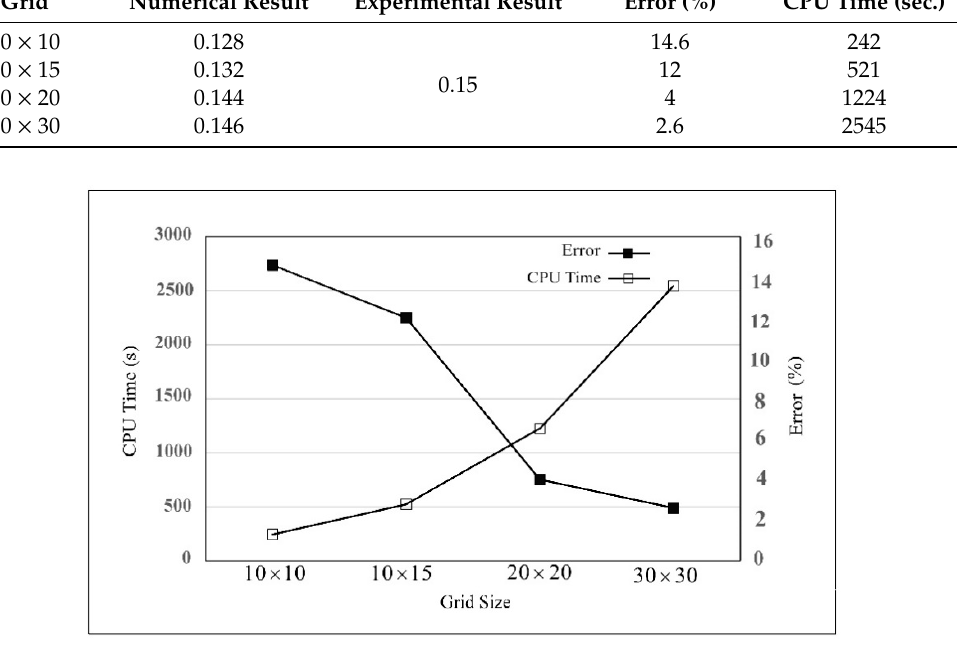
Figure 5. CPU Time and error for different grids ( J = 0.833 ) .